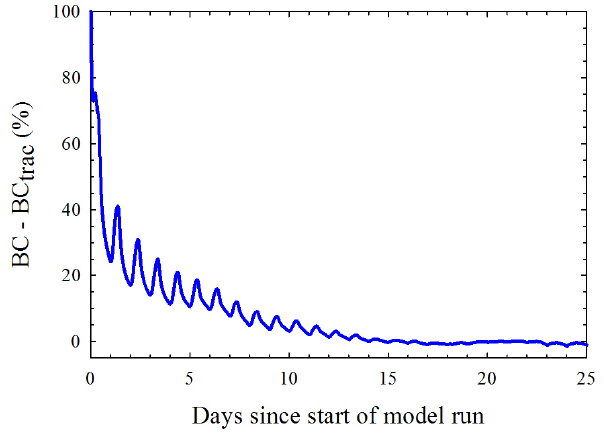
Figure 2. Time series of percentage difference between total simu- lated BC and sum of all the BC tracers (BC trac = BC-ANT + BC- BB + BC-BDY).